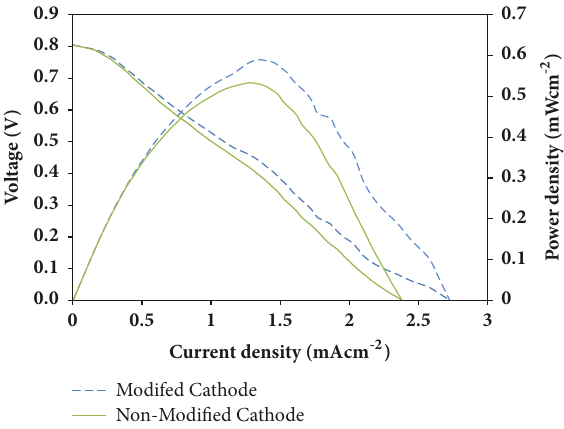
Figure 11: The polarization curve for self-pumping EBC with and without cathodic electrode CNTs/CA/CC.